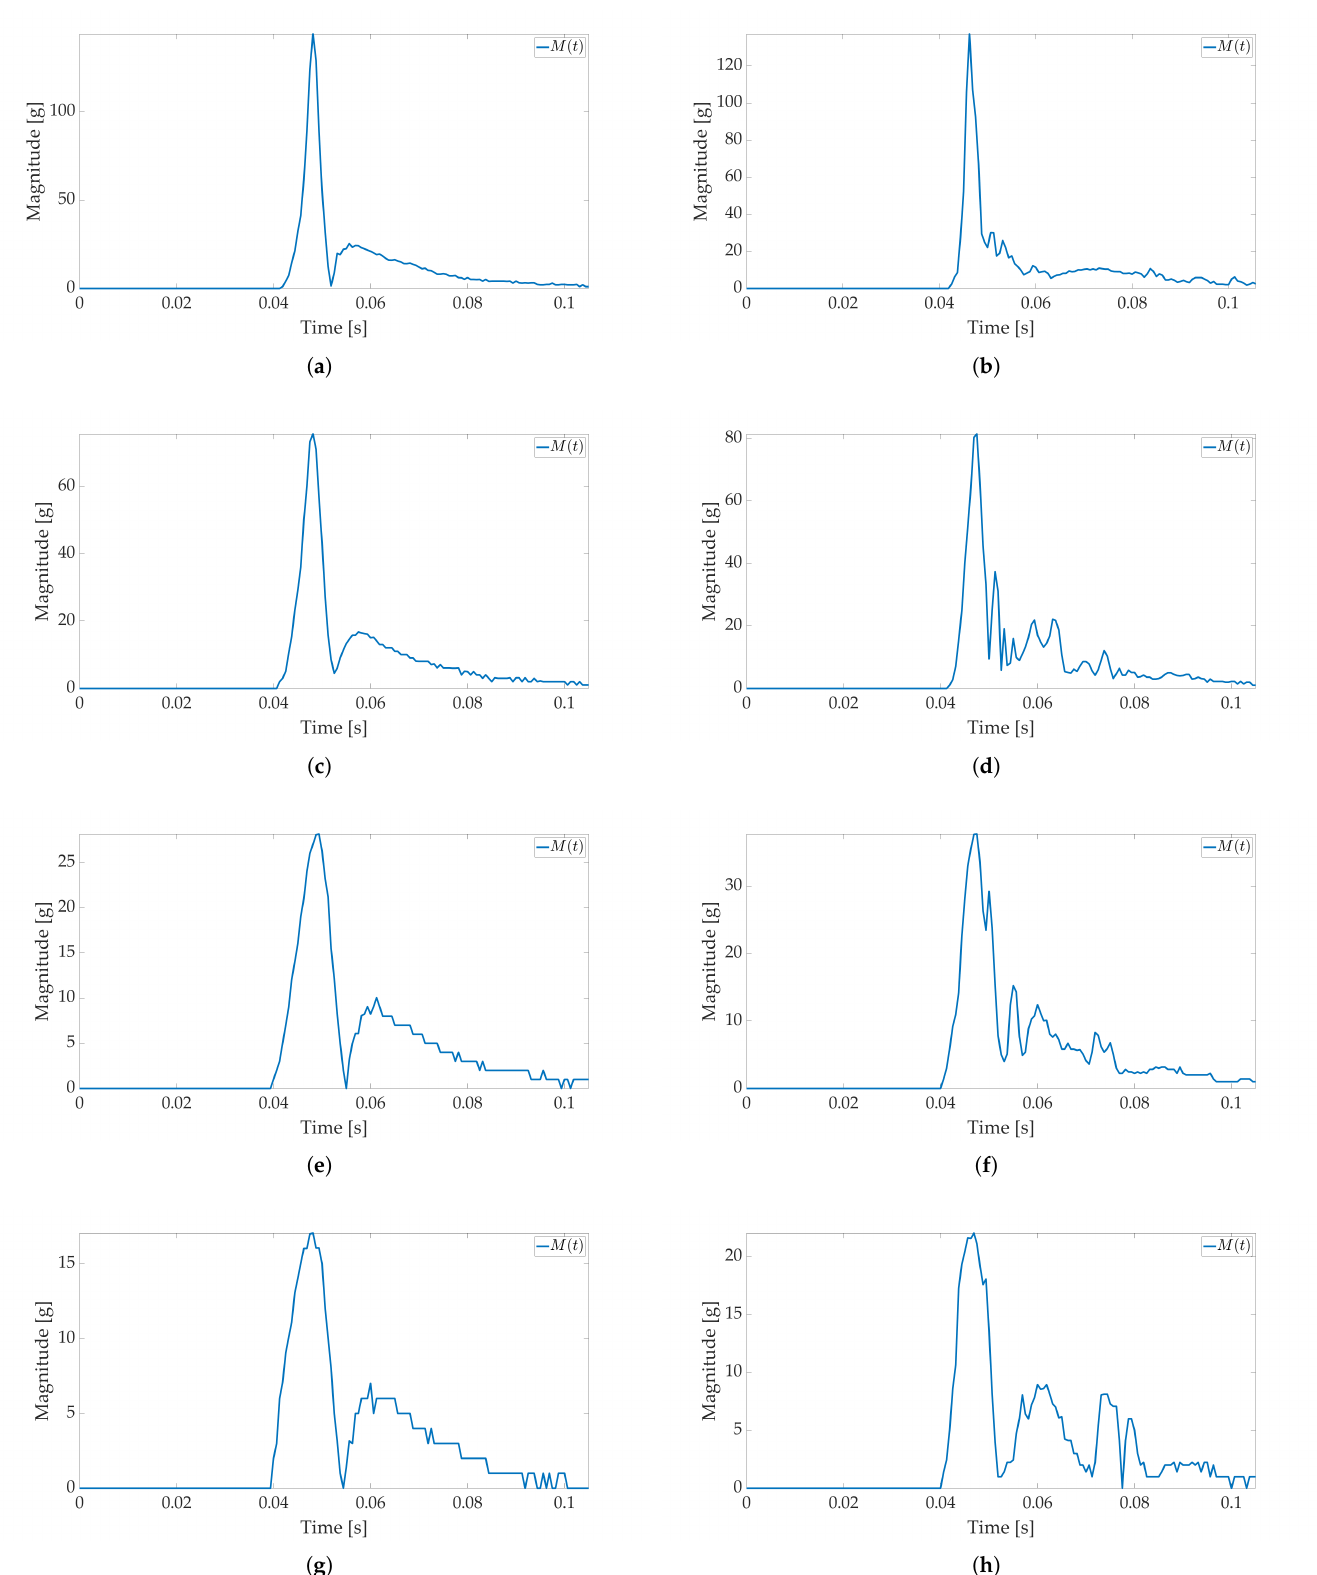
Figure 11. Shock detection values for package falling vertically from various heights (1600 Hz with FIFO). Acceleration magnitude waveform: measured inside the package on figures ( a ) (100 cm), ( c ) (50 cm), ( e ) (20 cm), ( g ) (10 cm); measured on the package on figures ( b ) (100 cm), ( d ) (50 cm), ( f ) (20 cm), ( h ) (10